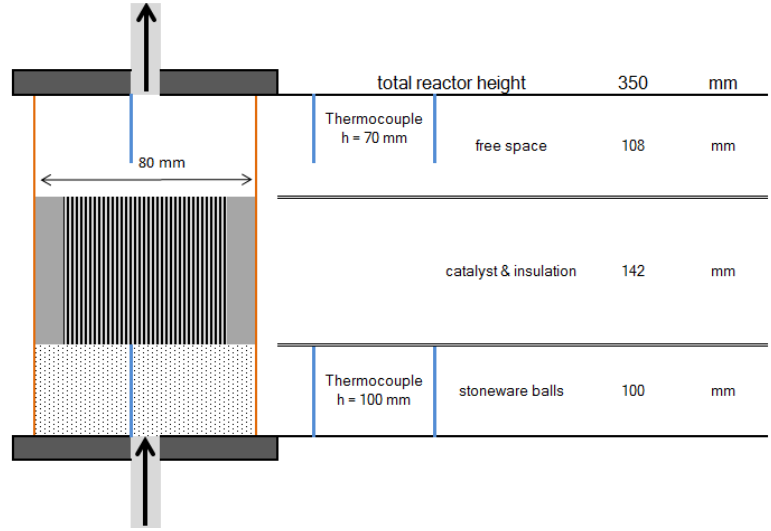
Figure 8. Schematic diagram of reactor setup.